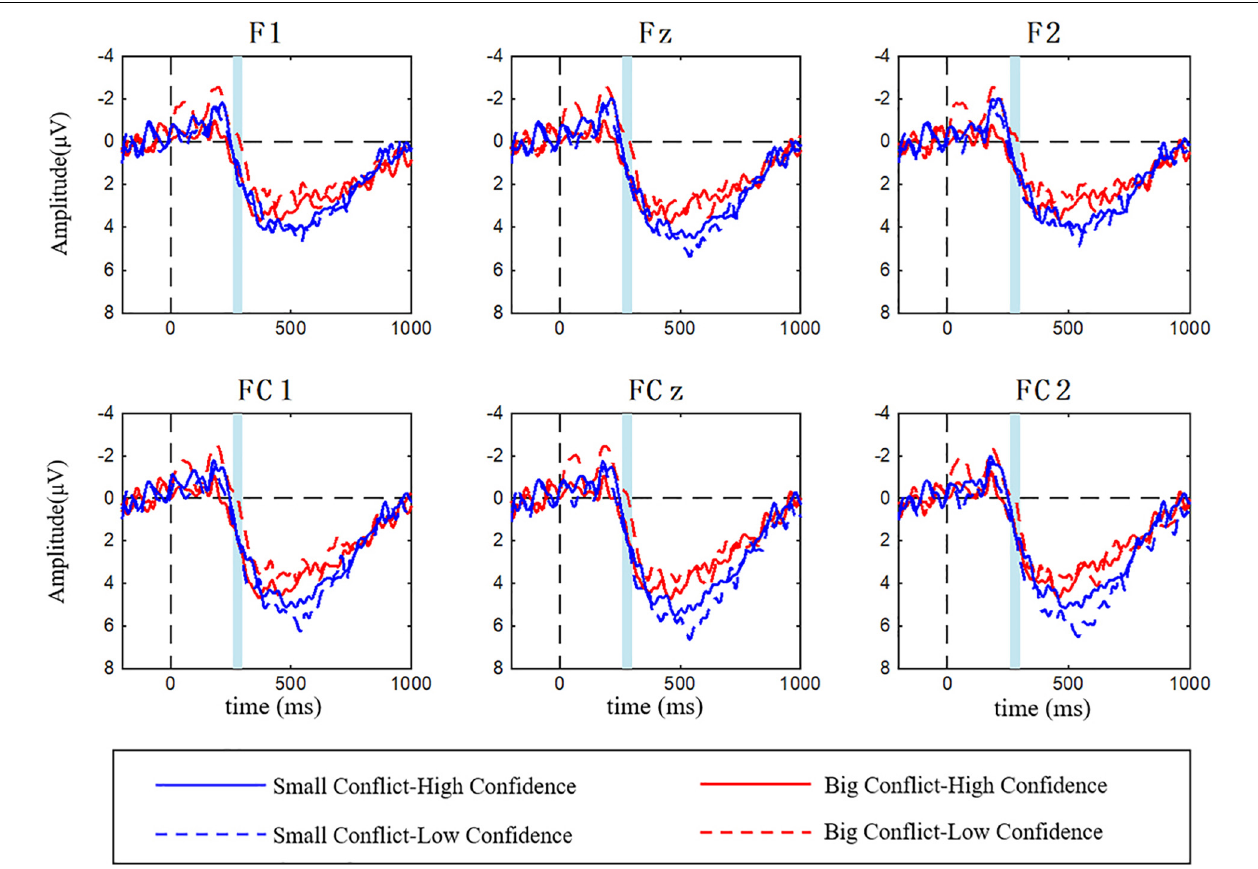
FIGURE 4 | Grand averaged ERPs elicited by confidence (low vs. high) × conflict magnitude (small vs. big) with FRN (the shaded area from 260 to 300 ms) at F1, Fz, F2, FC1, FCz, and